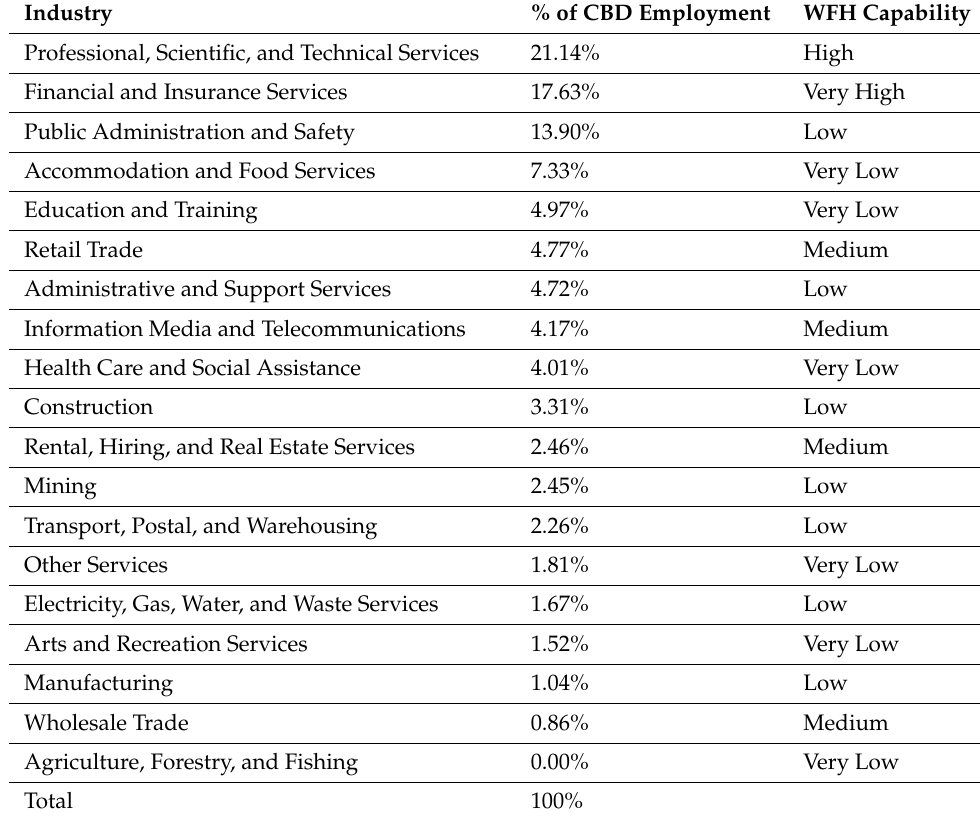
Table 1. Capacity of city centre workers with capability to work from